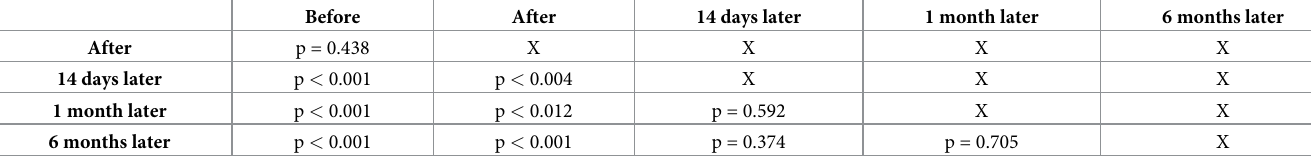
Table 1. The results of testing the levels of knowledge of students who participated in farm education in time. Before After 14 days later 1 month later After p = 0.438